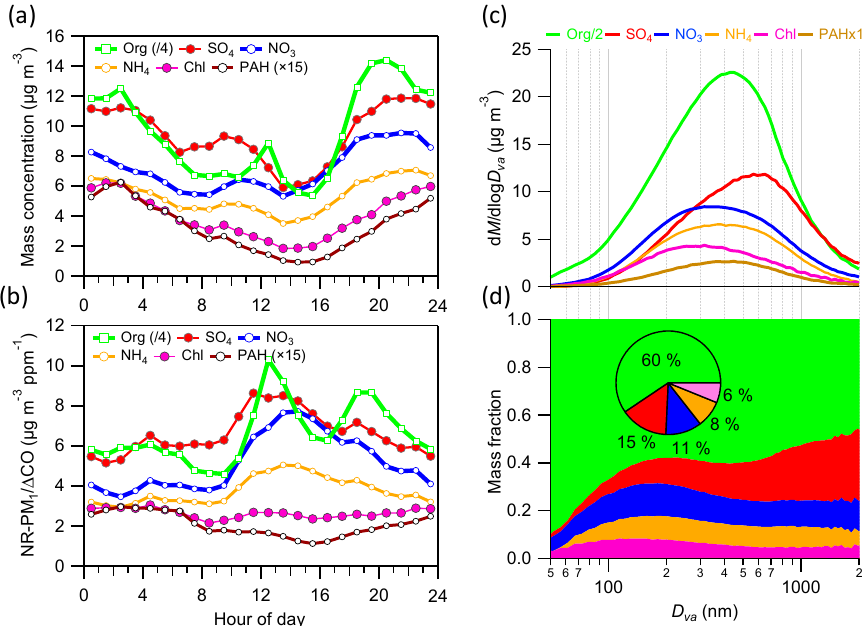
Figure 4. Average diurnal cycles of (a) NR-PM 1 species and (b) NR-PM 1 species/ (cid:49) CO, panels (c) and (d) show the average mass size distributions of NR-PM 1 species. The pie chart in panel (d) shows the average chemical composition of NR-PM 1 for the entire study